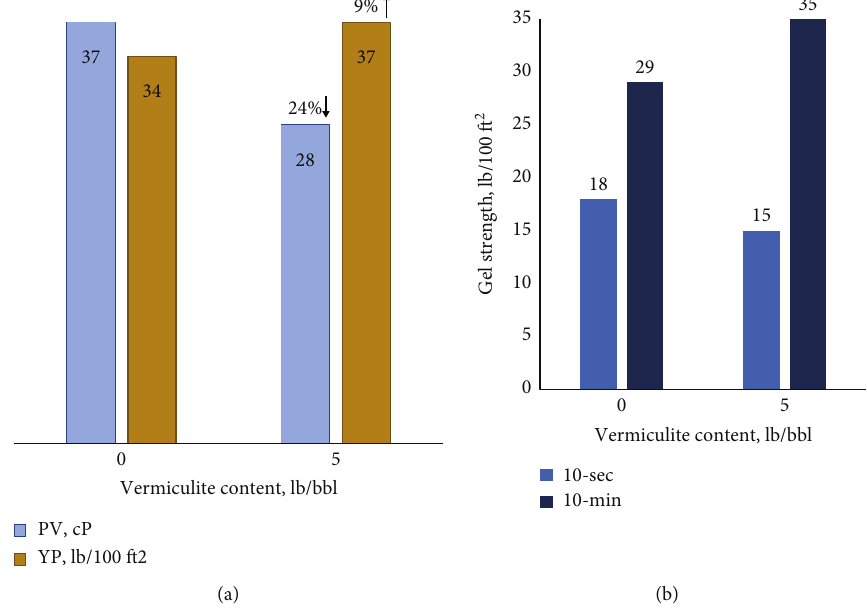
Figure 5: E ff ect of adding 5lb/bbl vermiculite on (a) plastic viscosity and yield point and (b) gel strengths at 250 °